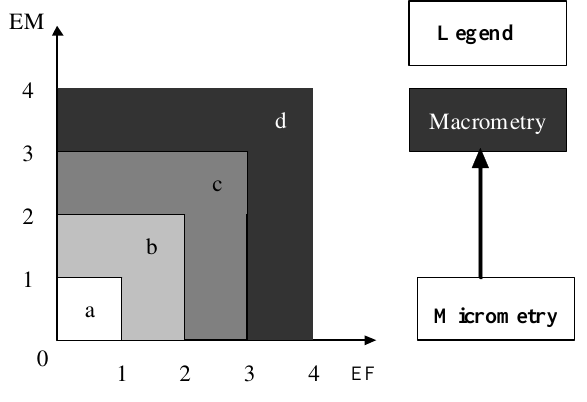
Figure 5 . Fields formed by distance variable